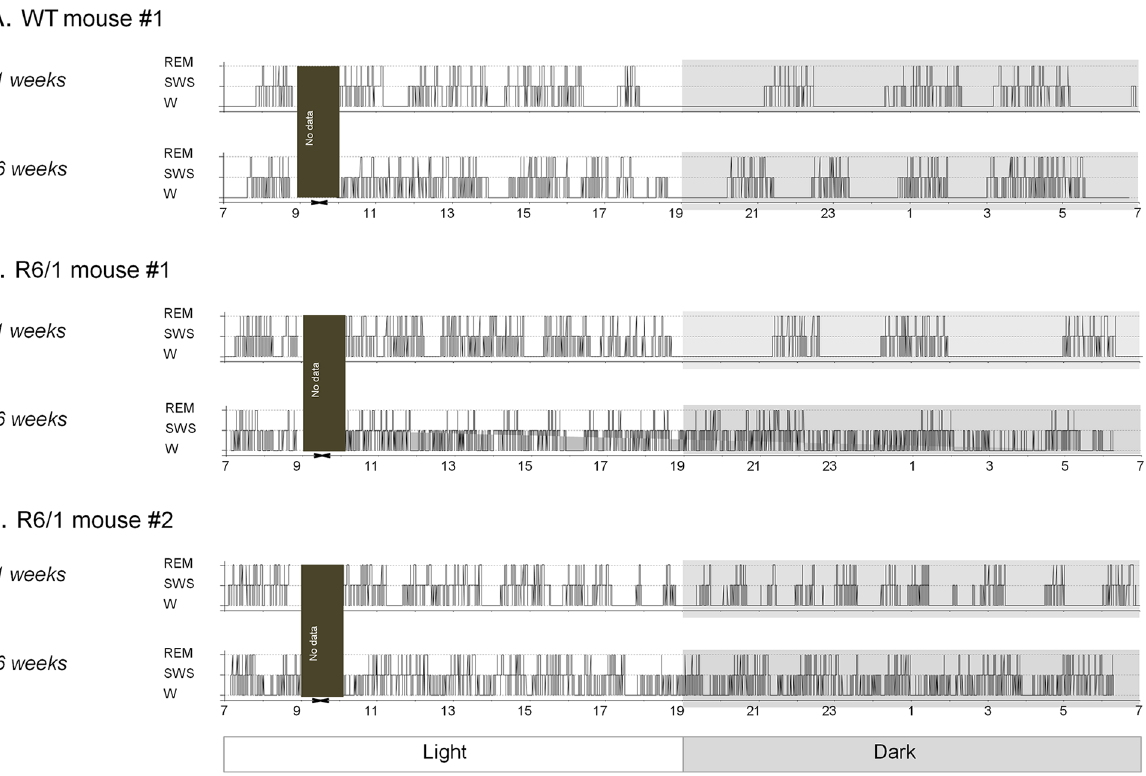
Fig 1. Example of sleep hypnograms of one WT (A) and two R6/1 mice (B-C) at 11 and 16 weeks ages. W: waking, SWS: slow wave sleep, REM: REM sleep.